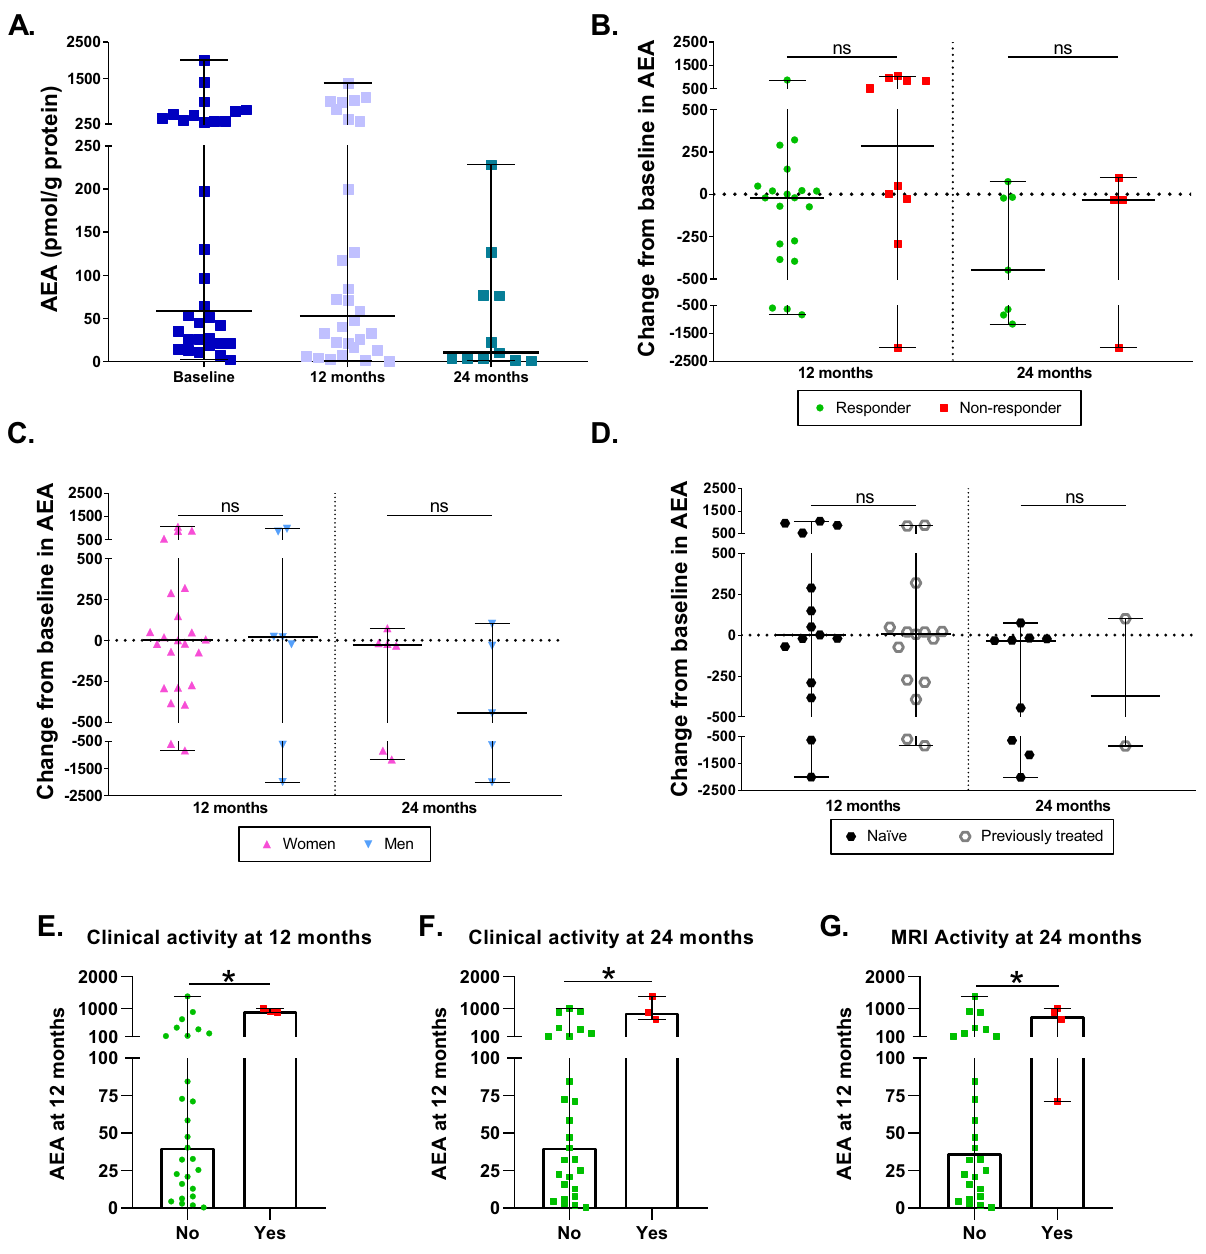
Figure 3. Characterization of AEA levels during DMF treatment. ( A ) AEA levels in MS patients at baseline and after 12 and 24 months of DMF treatment. ( B ) Changes in AEA levels at 12 and 24 months compared to baseline between responders and non-responders to DMF. ( C ) Changes in AEA levels at 12 and 24 months compared to baseline between women and men. ( D ) Changes in AEA levels at 12 and 24 months compared to baseline between naïve and previously treated patients. ( E ) AEA at 12 months in patients with (yes) or without (no) clinical activity at 12 months. ( F ) AEA at 12 months in patients with (yes) or without (no) clinical activity at 24 months. ( G ) AEA at 12 months in patients with (yes) or without (no) MRI activity at 24 months. The Wilcoxon test was used to compare differences between the different time points and baseline, and the Mann– Whitney test was used to compared differences between subgroups. Data are expressed as median with range in pmol/g of protein. *p < 0.05; ns, not